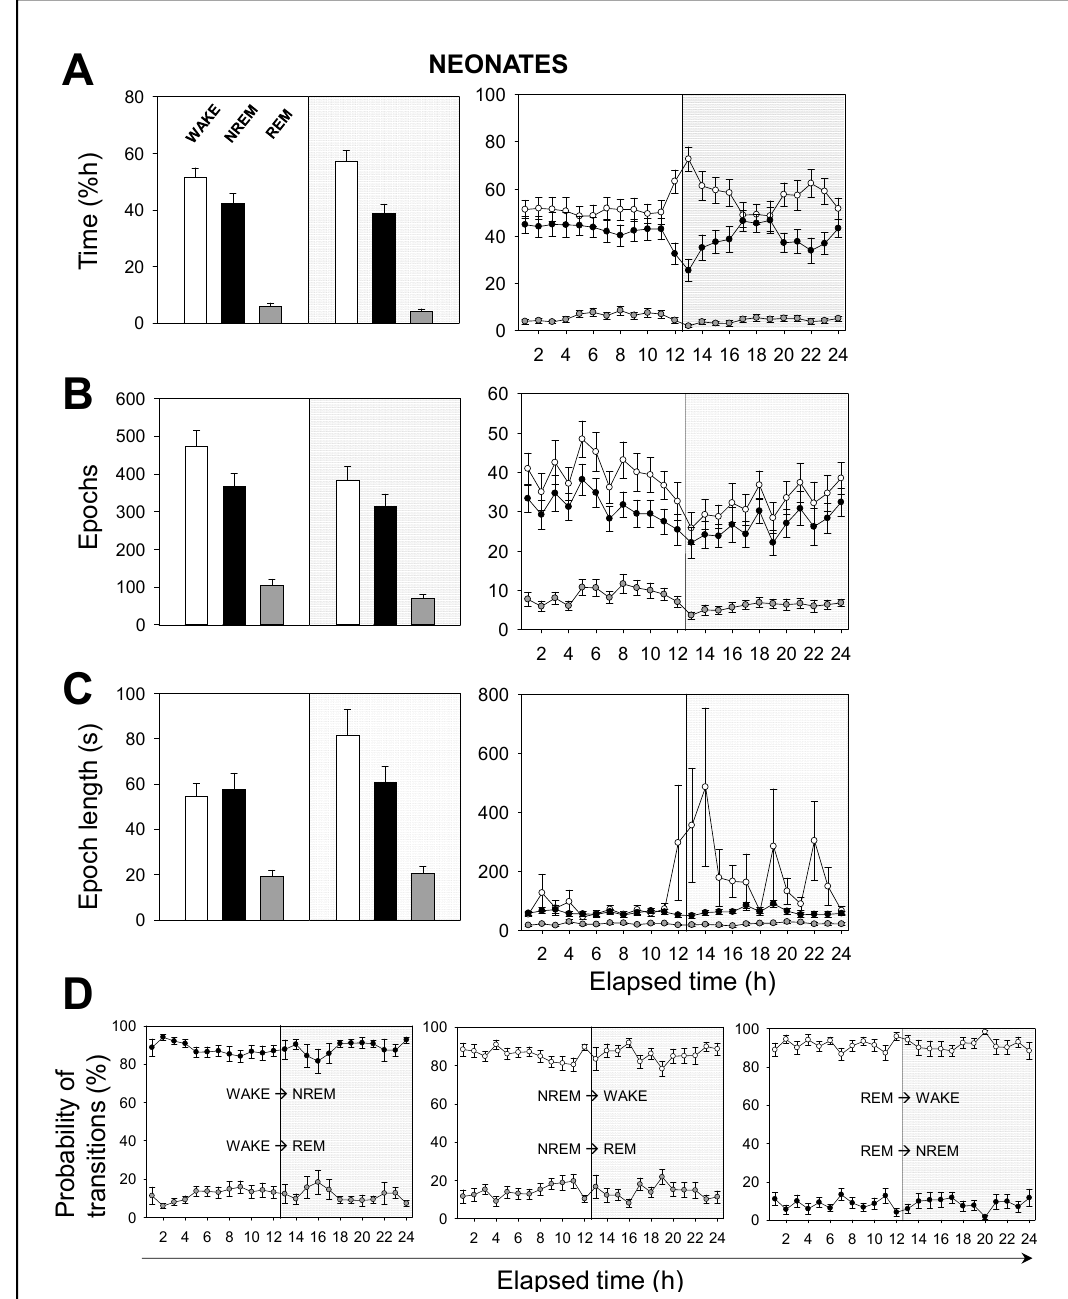
Figure 2. Sleep–wake characterization in neonatal mice. ( A ) Percentage of time spent, ( B ) total number of epochs, and ( C ) epoch length. White, black, and gray bars represent wakefulness, NREM, and REM sleep states, respectively. Parameters in A, B, and C are calculated during a total of 12 h-light (white background) or 12 h-dark (gray background) phases (left panels) or across the recording time within the 24 h period (right panels). ( D ) Probability of behavioral state transitions for every hour during the recording session (1–24 h). Left panel: From wakefulness into NREM and REM sleep. Middle panel: From NREM sleep into wakefulness and REM sleep. Right panel: From REM sleep into wakefulness and NREM sleep. White, black, and gray circles represent wakefulness, NREM, and REM sleep states, respectively. Data shown as mean ± SEM of 18 recordings retrieved from 6 neonatal